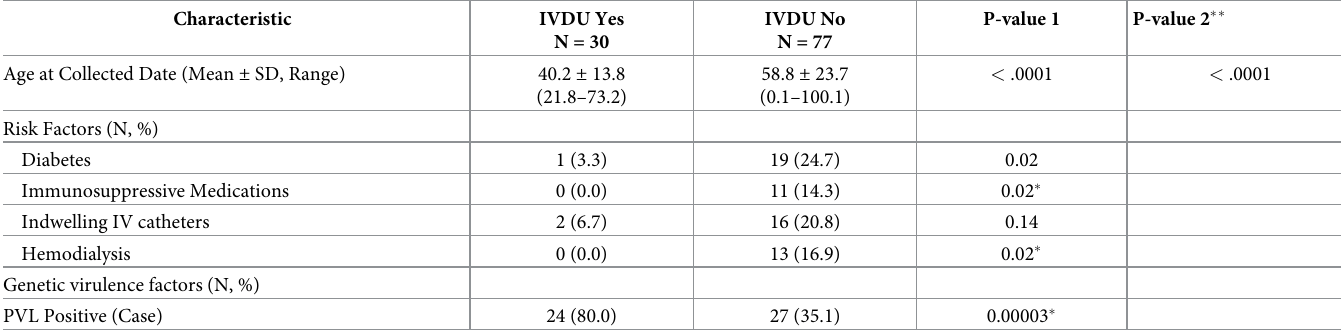
Table 7. Patient demographics by IVDU”